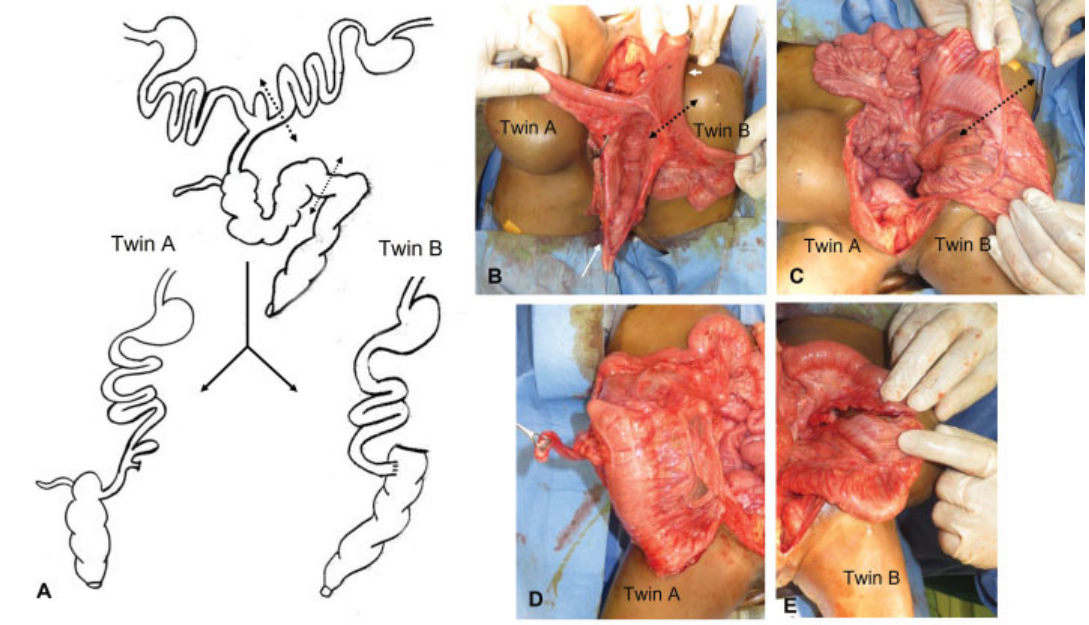
Fig. 4 Demonstration of GIT fusion in omphaloischiopagus conjoined twins. ( A ) Schematic diagram for the plan of separation; the dotted double arrow-head line marks for the two sites of division of the intestine: the small bowel of twin B is divided just before the point of union with the small bowel of twin A (at site of Meckel ’ s diverticulum), while the colon is divided in the middle; note that the bowel continuity is restored in twin B by performing ileocolic anastomosis. ( B – E ) The operative photos applying the same steps for separation. Note: the short white arrow in b is pointing to the Meckel ’ s diverticulum (site of fusion of small bowel of both twins); the long white arrow is pointing to the common terminal ileum. (C) The dotted double arrowhead line marks for the site ofdividing the common colon into equal proximal and distal segments. ( D ) Twin A kept his upper GIT in continuity with the common terminal ileum and proximal colon (with no anastomosis). ( E ) The distal end of the small bowel of twin B was anastomosed to the distal colon to restore the continuity of the GIT. GIT, gastrointestinal tract